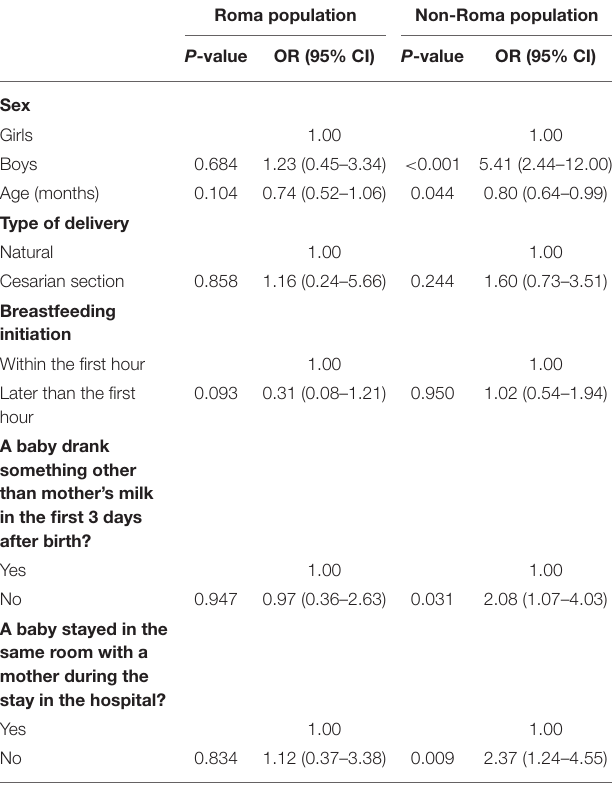
TABLE 4 | The associations between demographic and socio-economic characteristics of the family and the practice of exclusive breastfeeding—Univariate logistic regression (ULRA).